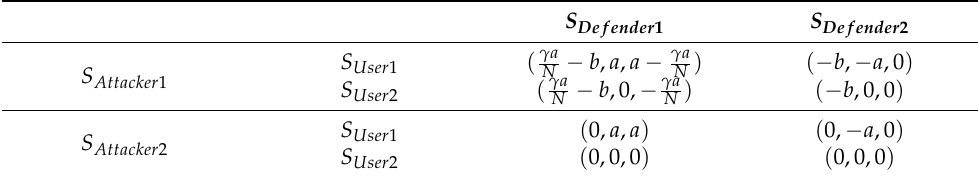
Table 4. Payoff matrix when providing real